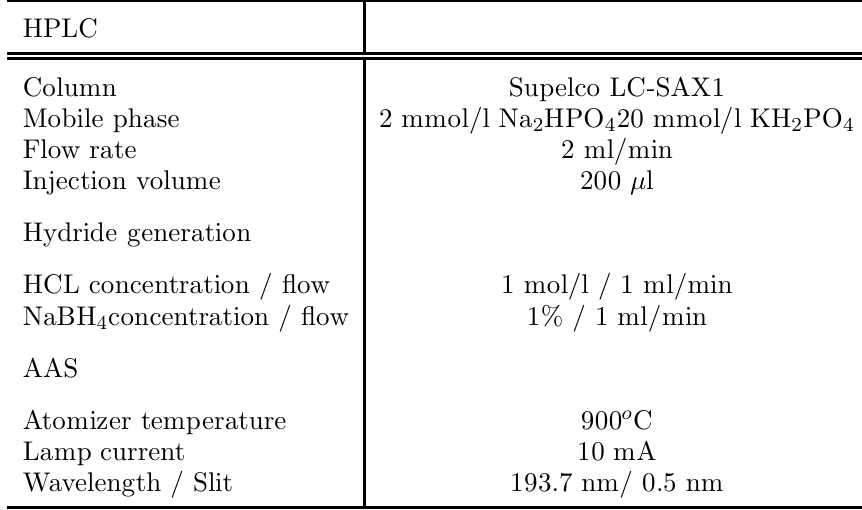
Table 1 Experimental condition for arsenic speciation analysis by